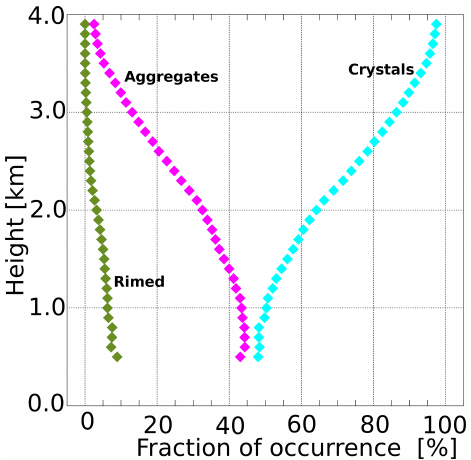
Figure 7. Fraction of occurrence of different hydrometeor types as a function of height above ground, obtained over the period of op- eration of MXPol, with the hydrometeor classification algorithm of Grazioli et al.